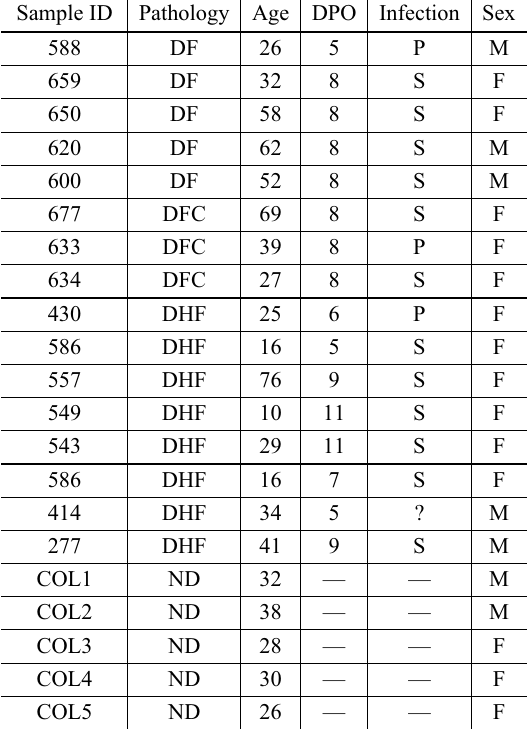
Samples used in the qPCR